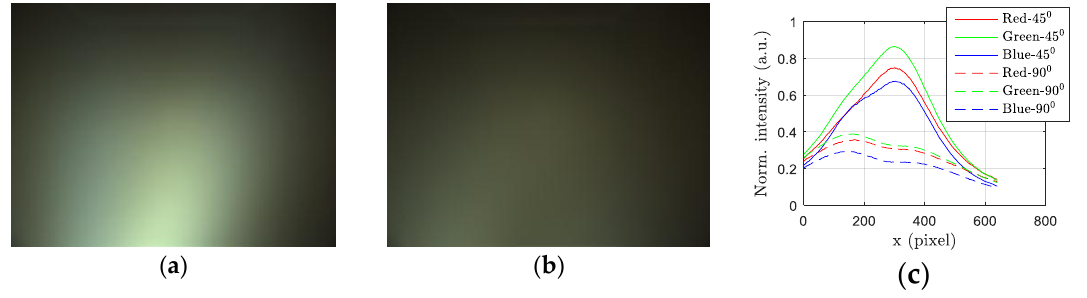
Figure A2. Effect of polarization in saturated backscattering: ( a ) Saturated backscattering of left camera when the polarization angle is 45°; ( b ) Saturated backscattering of left camera when the angle of polarization is 90°; ( c ) Intensity along x-axis at the section where intensity attains the highest value.